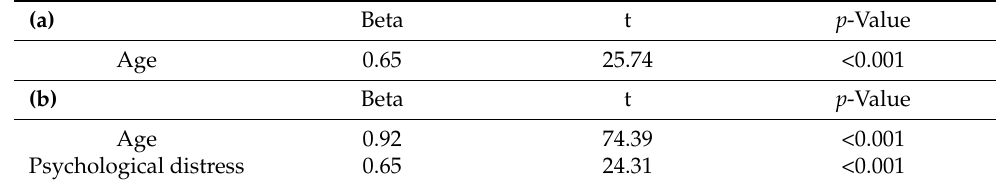
Figure 3. The mediation effects of type of education on the psychological distress. In the arrows are reported the β values about the effect of the age on the type of education (a), the effect of type of education on psychological distress (b), the total effect of the age on the psychological distress (c), and the direct effect of the age on the psychological distress controlling for the mediator. All p values were <0.001. Table 3. Results of the three regression analysis: (a) with “Psychological distress” as dependent vari- able; (b) with “Age” and “Psychological distress” as independent variables and “Type of education” as the dependent